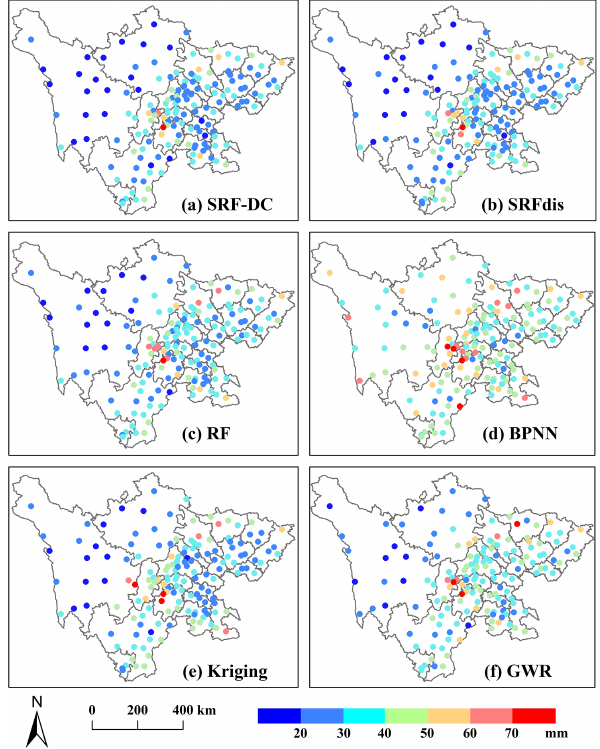
Figure 7. RMSE distributions of SRF-DC and some representative methods for all gauge stations on a monthly scale during 2015–